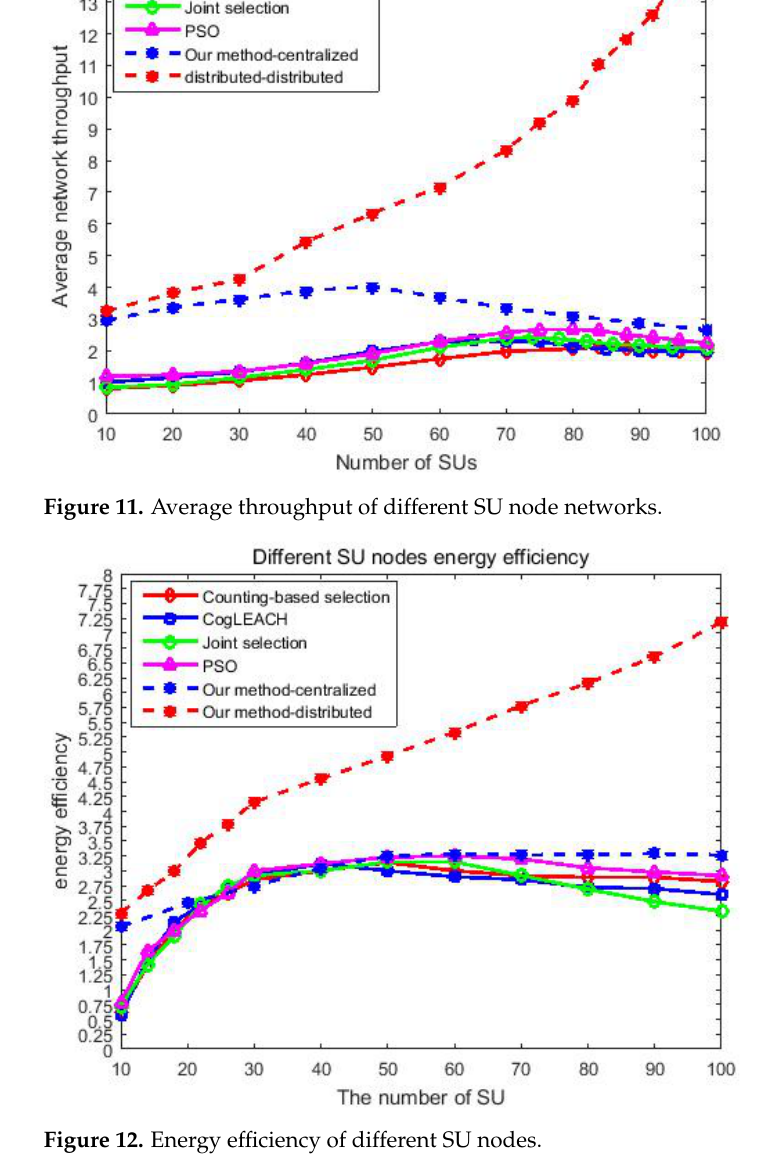
Figure 12. Energy efficiency of different SU nodes.